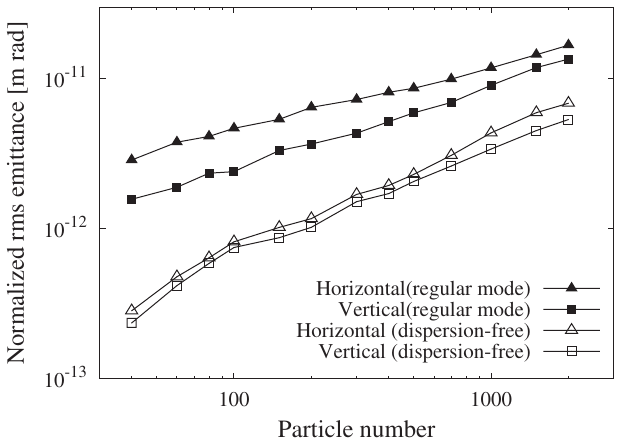
FIG. 8. Normalized rms emittances in the final equilibrium states reached at S-LSR after 3D untapered cooling. The three tunes have been adjusted at (cid:3) (cid:6) anisotropy parameter ~ (cid:10) is the same as in the cases of Figs. 3 and 5. The lattice functions of each operation mode have been plotted in Fig. 1. Other simulation parameters are summarized in Table I.